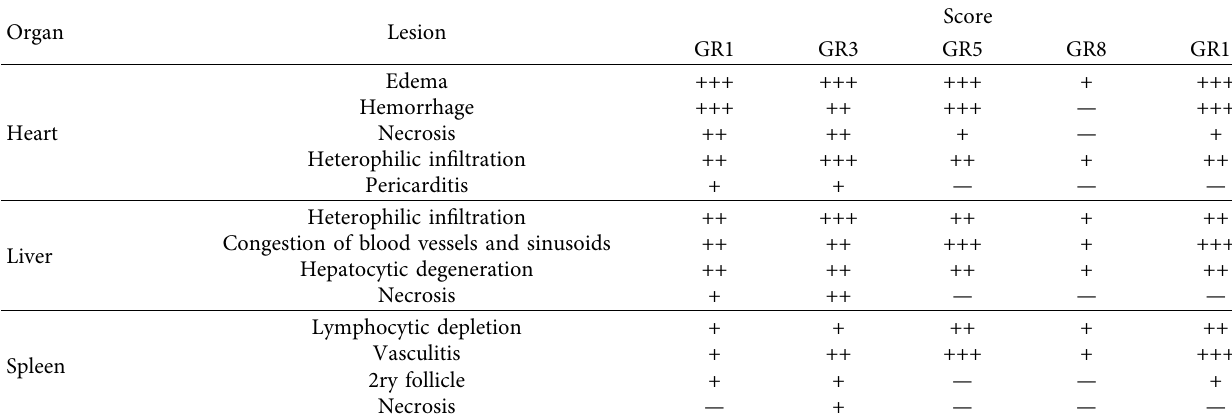
Table 9: Pathological lesions in groups infected with MDR strain 2 weeks after inoculation.